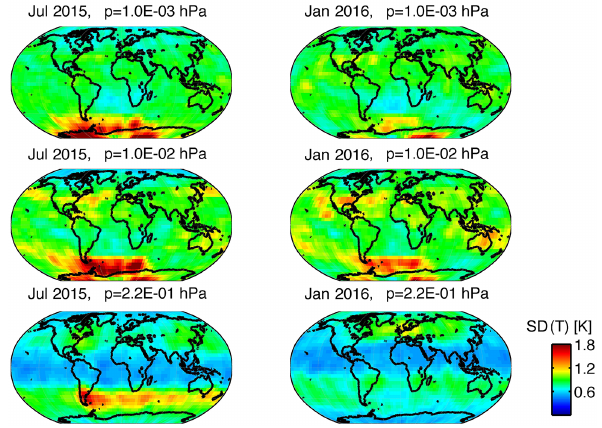
Figure 5. Global maps of inertia-gravity wave activity at various pressure levels in the mesosphere. SD( T ) can be regarded as the mean amplitude of the inertia-gravity waves.